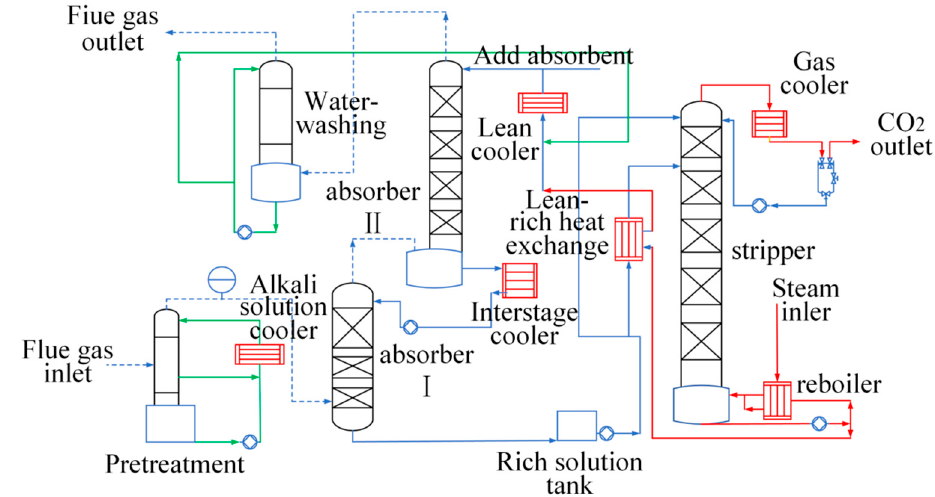
Figure 1. Process flowchart of the test platform.